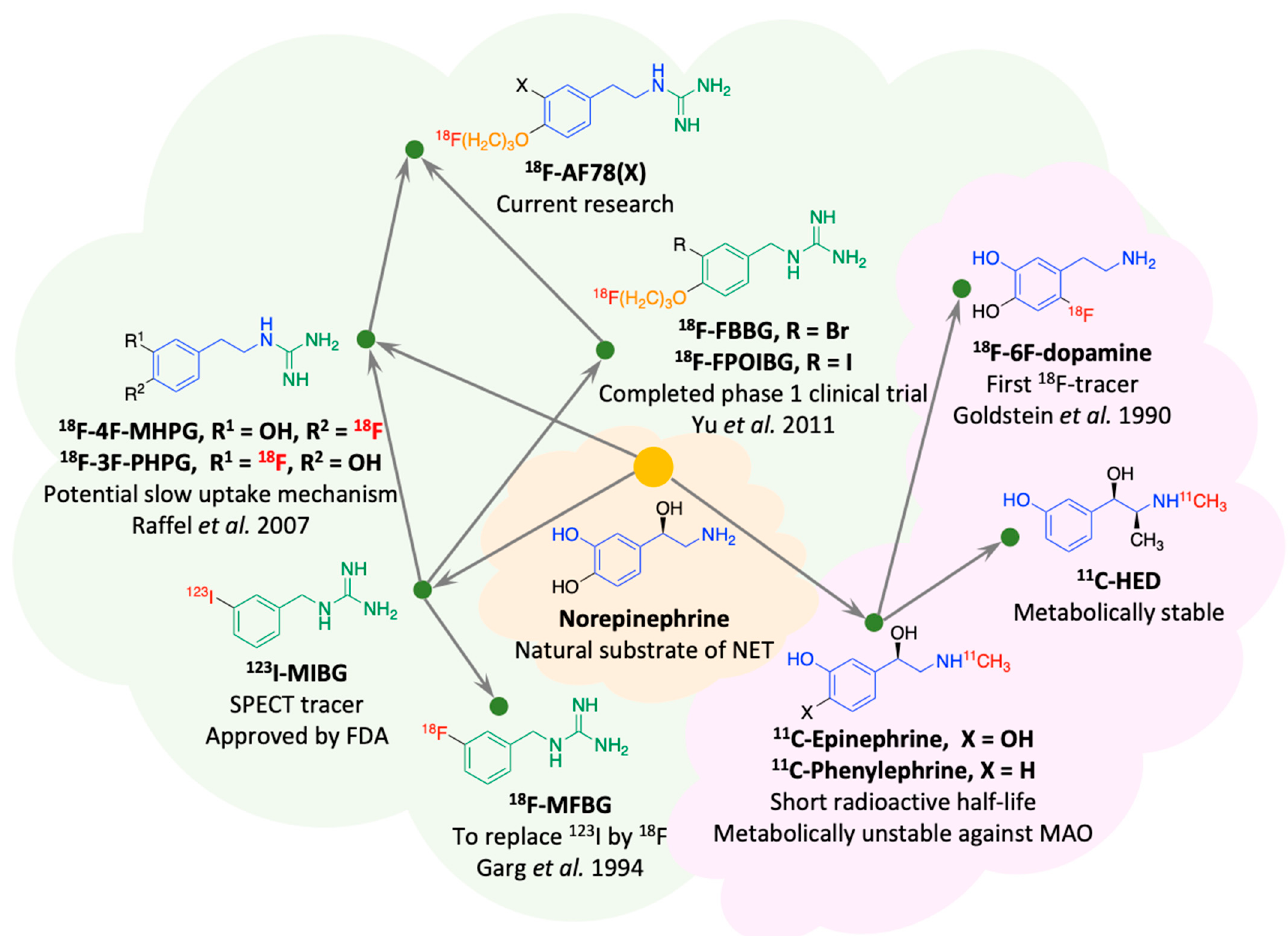
Figure 1. Evolutionary tree for the development of selected radiotracers targeting the norepinephrine transporter (NET), which can be categorized as monoamines (violet cloud) or guanidines (light green cloud) [4,8–11]. Blue and green represent the shared core structures of the radiotracers, orange represents the common “tail” structure, and red represents radionuclides.